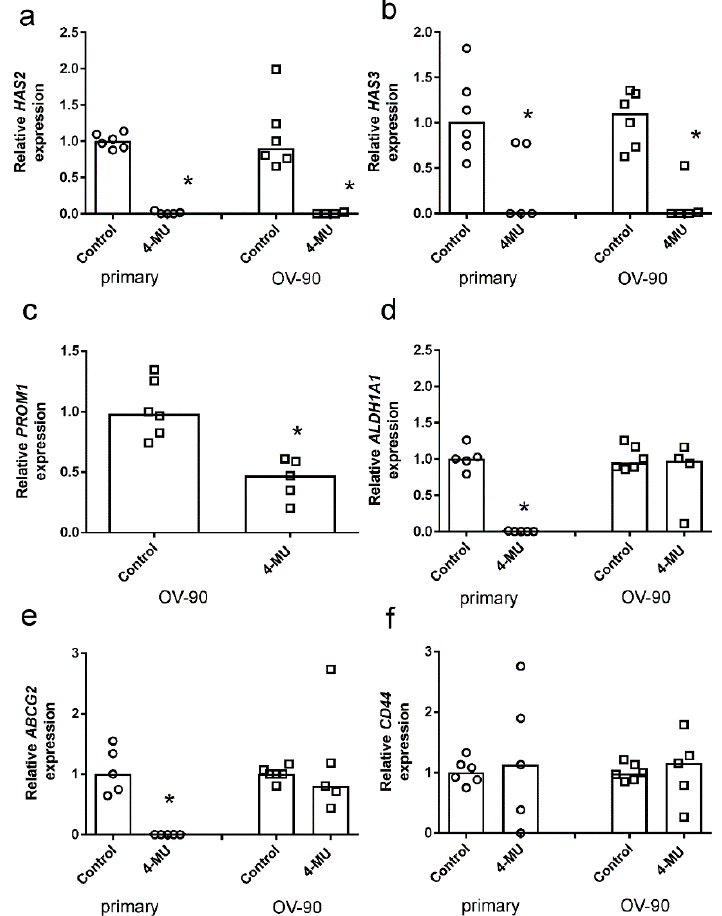
Figure 5. Effects of 4-methylubelliferone (4-MU) on stem cell marker expression in spheroids . Expression of stem cell markers in spheroids from a chemotherapy-resistant primary serous ovarian cancer and OV-90 cells treated with control media or 4-MU (1 mM) for 72 h. HAS2 ( a ), HAS3 ( b ), PROM1 ( c ), ALDH1A1 ( d ), ABCG2 ( e ), and CD44 ( f ). Data are expressed as the median from RNA samples ( n = 5–6) from three independent experiments. *, significantly different from control, ( p < 0.05, Mann Whitney U test).